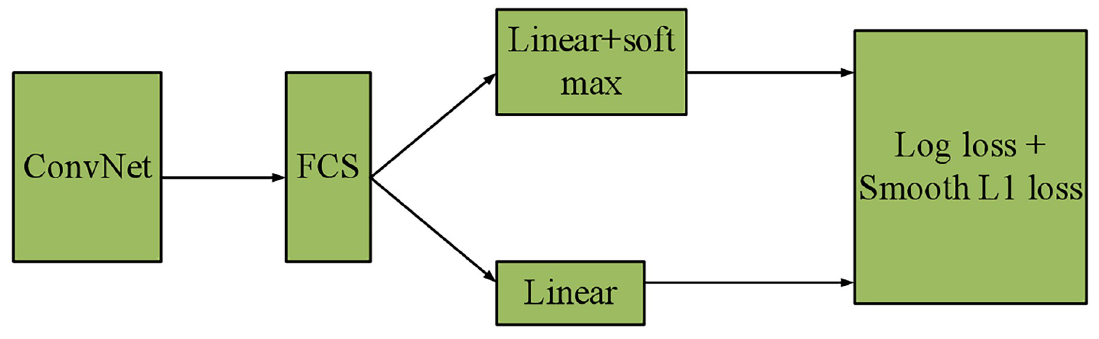
Fig 1. Structure of Fast R-CNN.